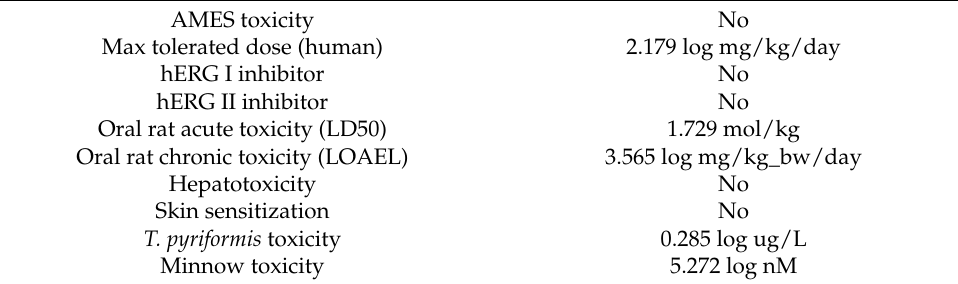
Table 5. In silico Toxicity properties of